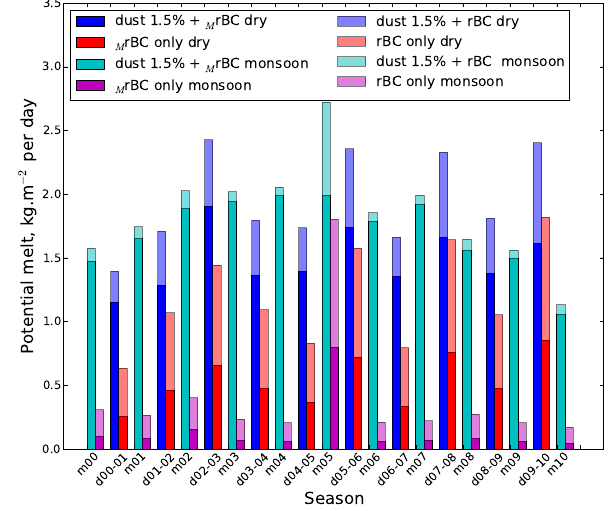
Figure 8. Potential melt per day due to the presence of impurities in the snowpack for each dry (for example d04–05 correspond to the dry season 2004–2005) and monsoon (for example m09 correspond to the monsoon 2009) season in the study. The hematite content used is 1.5%. For each season, the first bar (blue or turquoise) cor- responds to the presence of both dust and BC, the second (red or pink) to BC